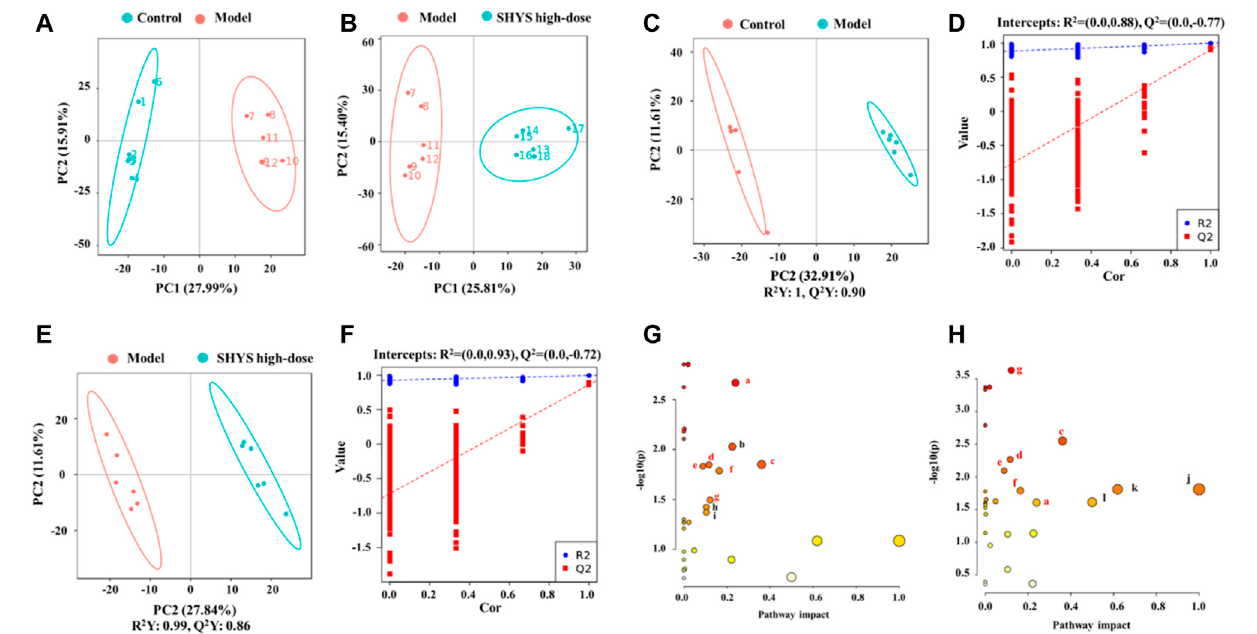
FIGURE 4 | SHYS treatment modulated the serum metabolites in DN rats (A,B) Scores plots of PCA between the Control and Model groups (A) and between the Model and SHYS high-dose groups (B – D) Scores plots of OPLS-DA between the Control and Model groups and the corresponding coef fi cient of loading plots. (E,F) Scores plots of OPLS-DA between the Model and SHYS high-dose groups and the corresponding coef fi cient of loading plots (G,H) Summary of pathway analysis of serum samples between Control and Model groups (G) and between Model and SHYS high-dose groups (H) , the sames pathways were written in red. a: Glycerophospholipid metabolism; b: Tryptophan metabolism; c: Alanine, aspartate and glutamate metabolism; d: Arginine biosynthesis; e: TCA cycle; f: Tyrosine metabolism; g: Arginine and proline metabolism; h: Cysteine and methionine metabolism; i: Glycerolipid metabolism; j: Phenylalanine, tyrosine and tryptophan biosynthesis; k: Phenylalanine metabolism. Control, Model and SHYS high-dose ( n (cid:2) 6 per group)